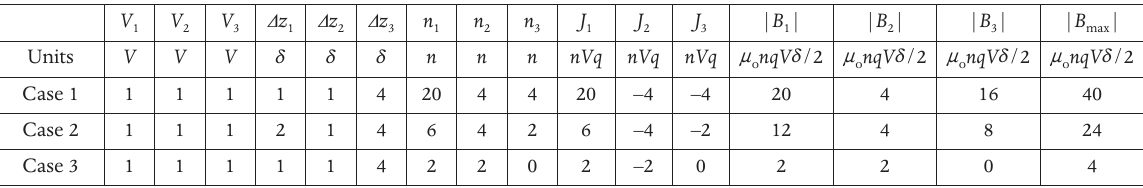
Table 2. Cases depicted in Figure 6d-f. In line 1, suffix 1 refers to the lowest sheet, suffix 2 to the intermediate sheet, suffix 3 to the top sheet. All of the quantities are expressed as multiples of reference values shown in the row of Units. V , d , n , J and B are respectively: charge velocity, sheet thickness, charge density, current density and magnetic field reference values (i.e. units). V and q are a reference velocity and unitary charge. B is the permeability of free magnetic field. n o